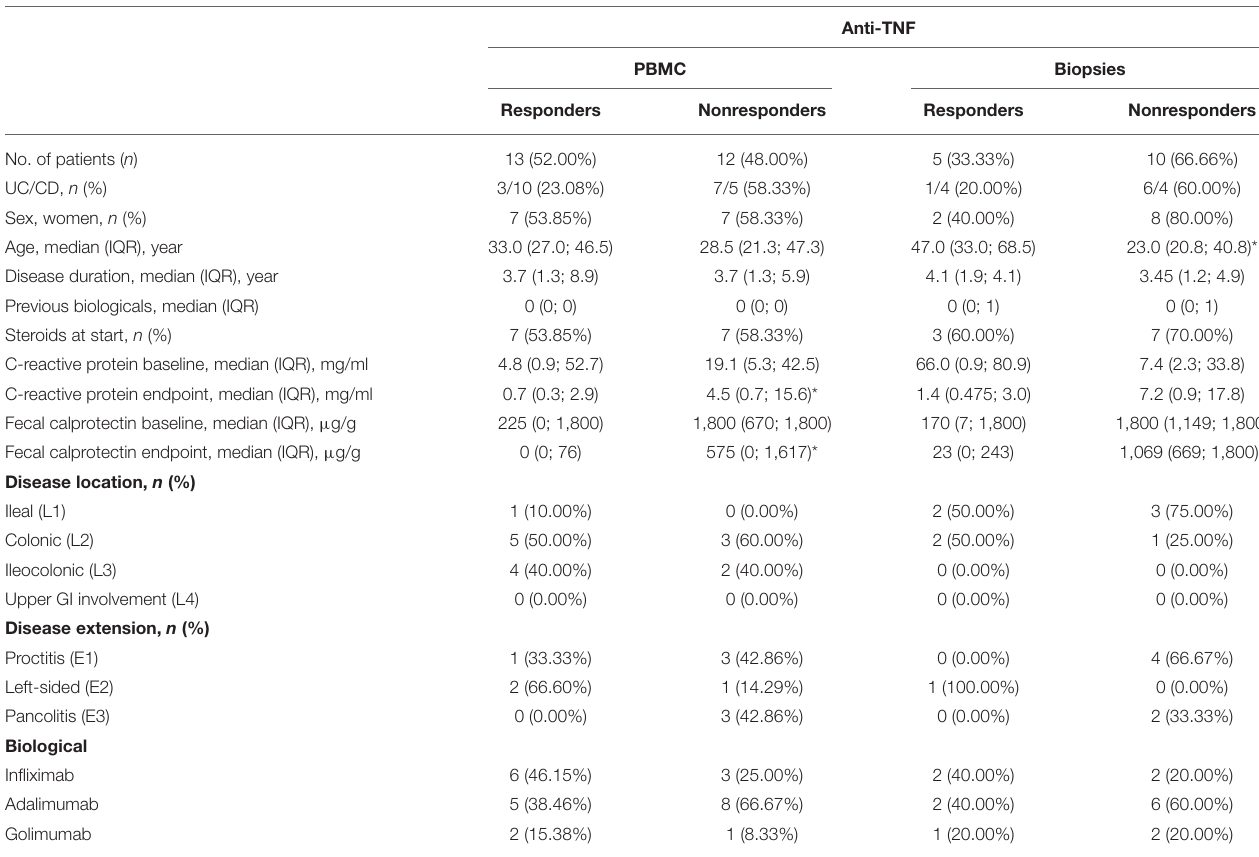
TABLE 3 | Demographic characteristics of patients on anti-TNF